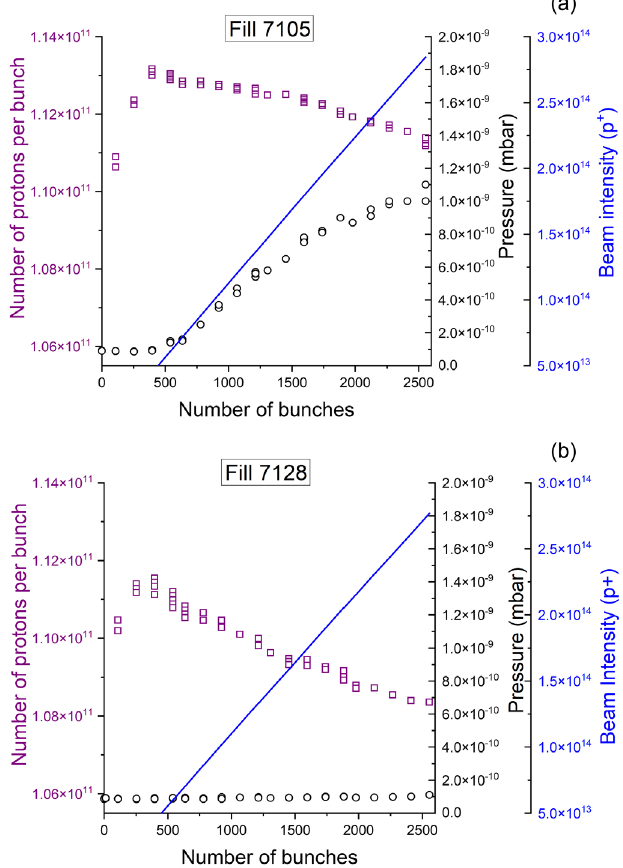
occurred.FIG. 4. Evolution of the number of protons per bunch, pressure and intensity of beam 1 in station 4 as a function of the number of bunches during injection at 450 GeV for fill 7105 (a) and fill 7128 (b),